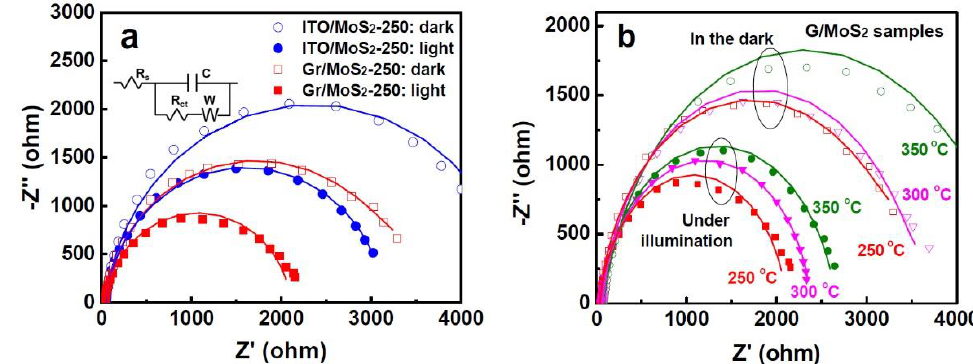
Figure 6. ( a ) Nyquist plots of ITO/MoS 2 -250 and G/MoS 2 -250 in the dark and under illumination. The inset shows an equivalent Randles circuit. ( b ) Nyquist plots of G/MoS 2 -250, G/MoS 2 -300, and G/MoS 2 -350.